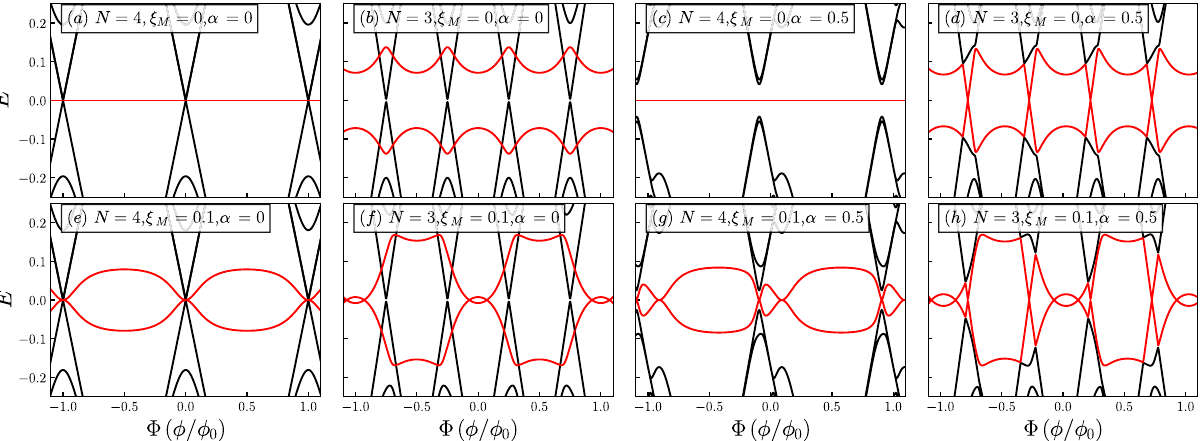
Figure 3. Quasiparticle spectra for (cid:31) 1 = 0.1 and (cid:31) 2 = 0.15 . The number of sites, N , the coupling between MZMs, ξ M , and the Rashba spin-orbit coupling, α , are indicated in the figure. Black curves represent the states in the quantum ring and the red curves correspond to the Majorana